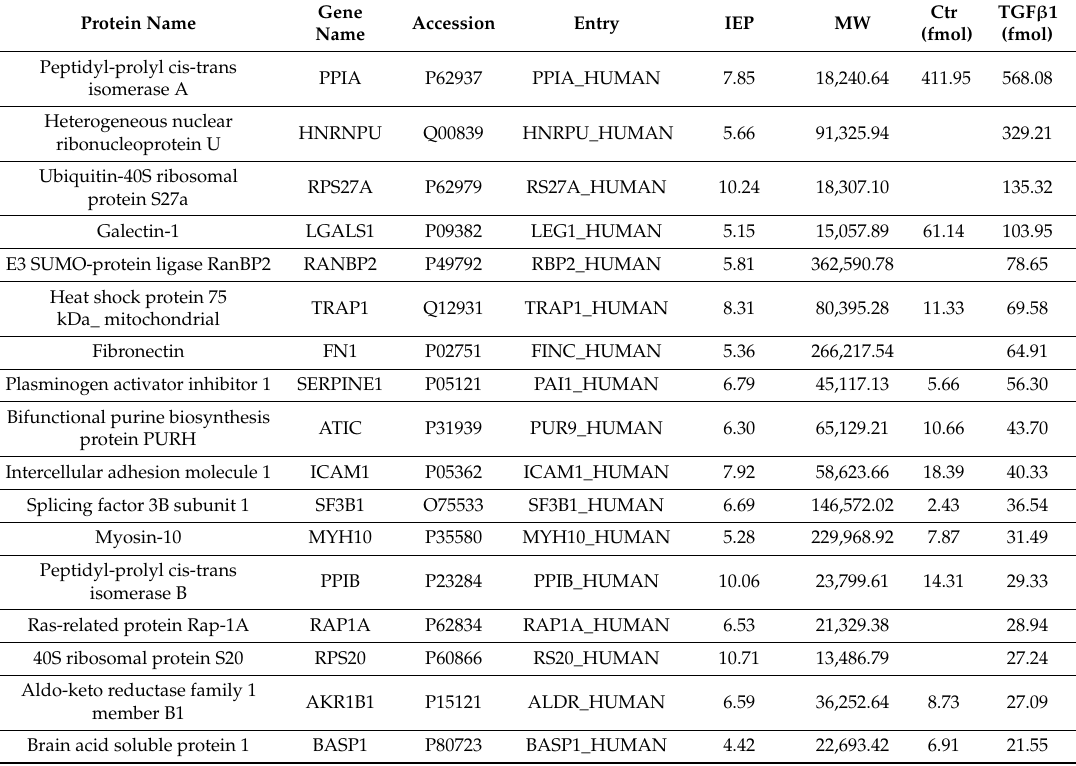
Table 1. List of proteins identified after co-immunoprecipitation with anti-PPIA antibody and mass spectrometric analysis. The identified proteins were quantified, and their amount is given in fmol. Listed are the potential interaction partners of PPIA under TGF β 1 treatment. These proteins bind to PPIA only under TGF β 1 treatment. The gene name, accession number in Swiss-Prot, molecular weight, entry, isoelectric point, and the amount in fmol are